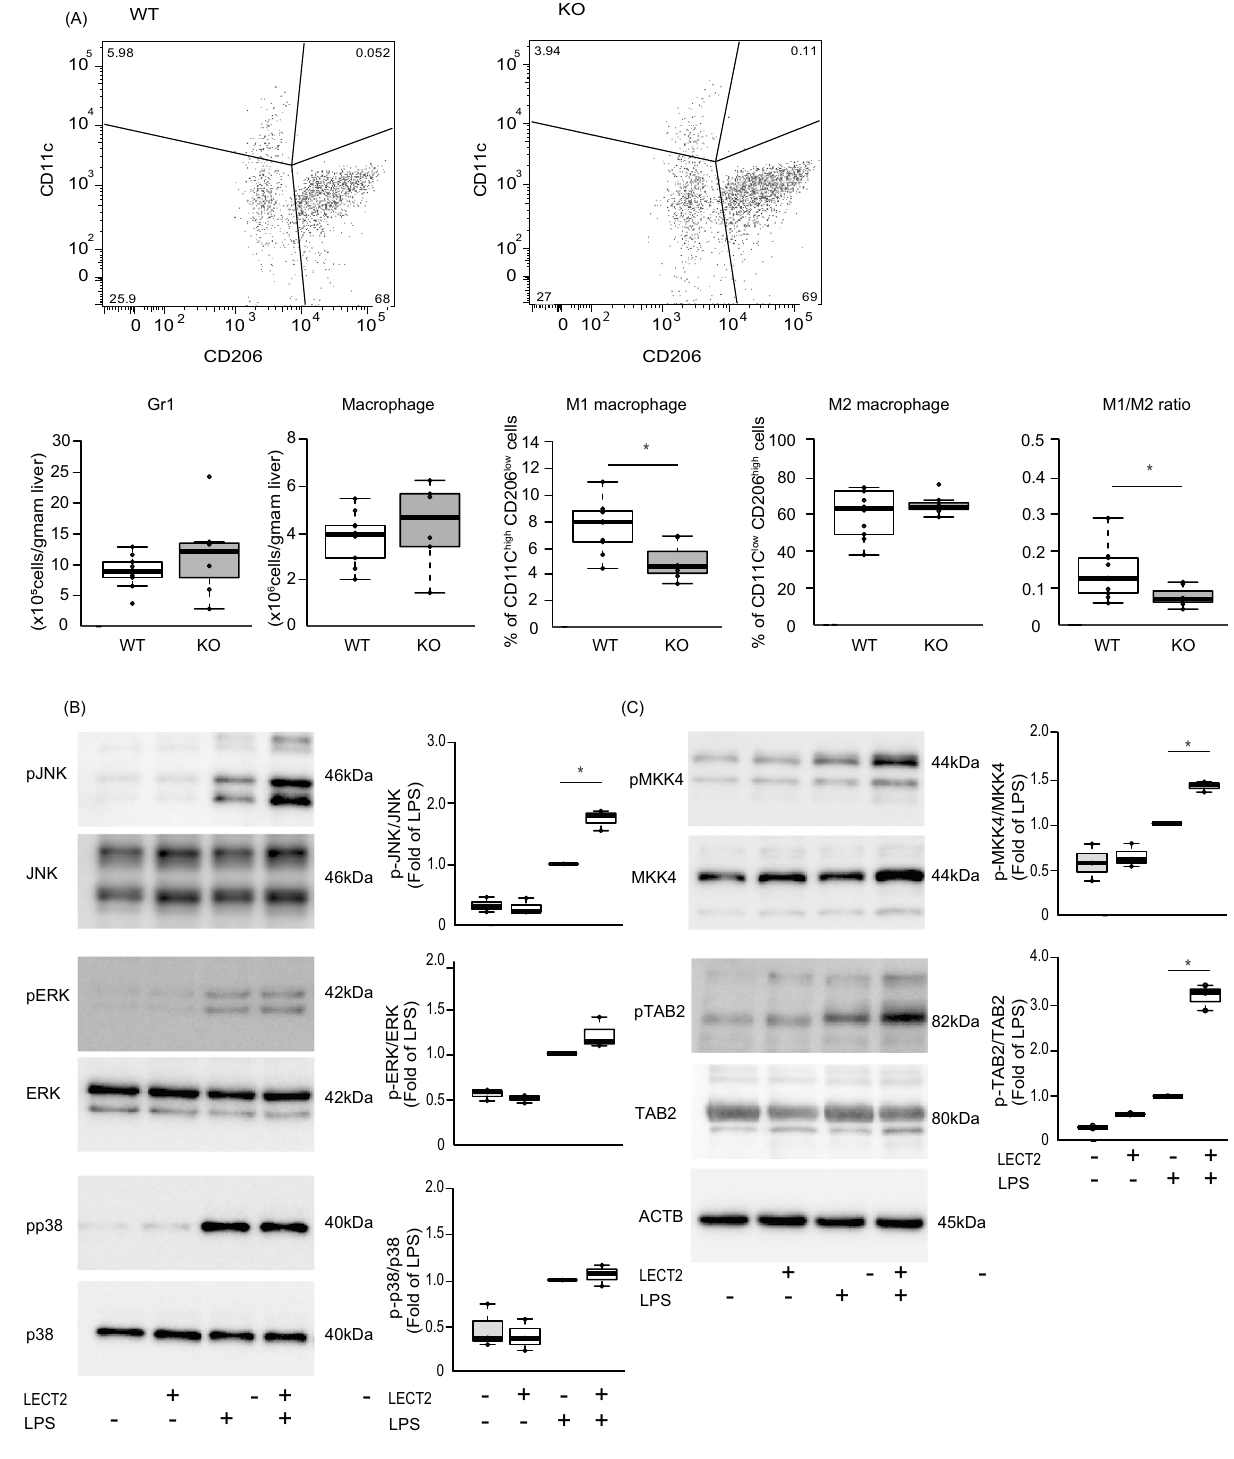
Figure 3. LECT2 changed the percentage of M1-like macrophages and M2-like macrophages in the liver of C57BL6 mice and enhanced LPS signaling in KUP5. ( A ) Flow cytometry analyses of the liver from wild-type and Lect2 KO mice fed an HFD for 4 weeks. The representative plot demonstrates macrophage populations in the liver of Lect2 KO mice fed an HFD. CD11c high /CD206 low and CD11c low CD206 high populations were defined as M1-like and M2-like macrophages, respectively. Graphs show quantitation of Gr1-positive macrophages, F4/80 CD11b-positive macrophages, percentages of M1-like macrophages, and percentages of M2-like macrophages (n = 7, 10). B: Western blot analysis of LPS (400 ng/mL)-stimulated JNK, ERK and p38 phosphorylation in KUP5 treated with LECT2 (400 ng/mL). The cells were treated with LPS and LECT2 protein for 30 min (n = 3). ( C ) Western blot analysis of LPS (400 ng/mL)-stimulated MKK4 and TAB2 phosphorylation in KUP5 treated with LECT2 (400 ng/mL). The cells were treated with LPS and LECT2 protein for 30 min (n = 3). *P <